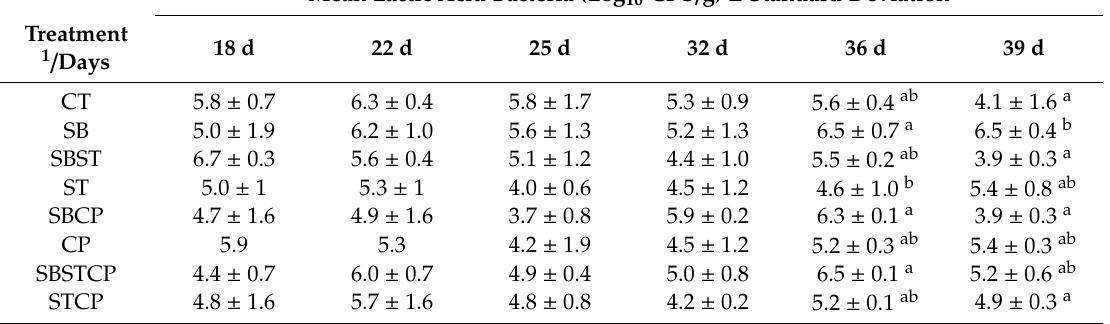
Table 2. E ff ect of dietary supplementation with a Synbiotic mix on duodenal Lactic Acid Bacteria counts of broilers challenged with Salmonella Typhimurium and Clostridium perfringens